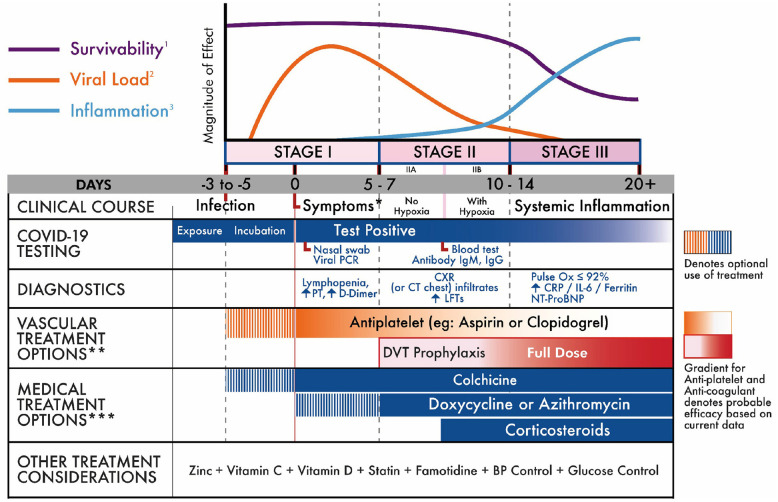
COVID-19 clinical stages and management strategy (15–17). *Initially mild in stage I (fever, cough, myalgia, other non-specific). May progress in stage II-III to severe dyspnea and respiratory distress (16, 18–20). **As with all treatment options, risks, and benefits should be carefully reviewed with the patient. ***No treatments are currently FDA approved for COVID-19 treatment. The FDA has approved remdesivir and convalescent plasma for inpatient use.